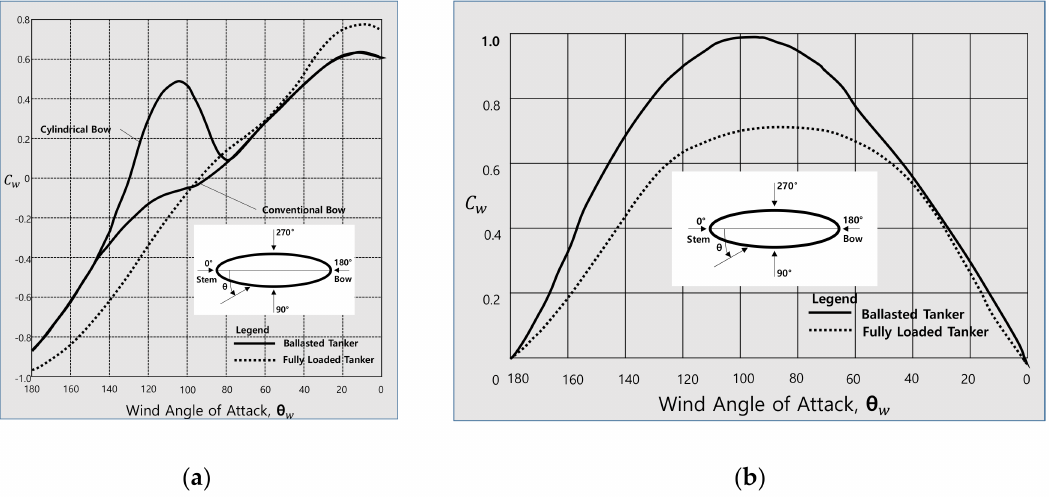
Figure 4. ( a ) Longitudinal and ( b ) lateral wind drag force coe ffi